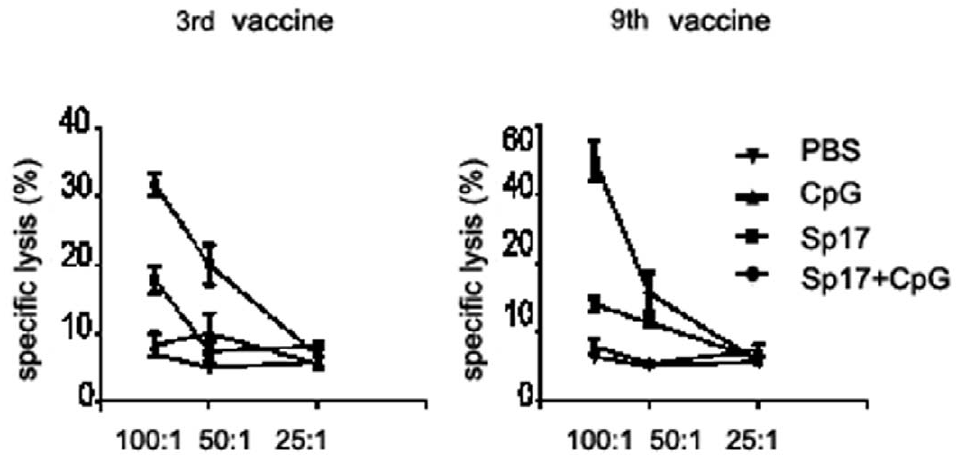
Figure 9. Cytotoxicity assay in the therapeutic regimen. Splenocytes from the three different formulations of therapeutically vaccinated mice and controls were collected and analyzed by 51 Chromium-release assay. These results show three independent experiments after third vaccine (day 97) and ninth vaccine (day 270), using splenocytes as effector cells and ID8 as target cells. X axis indicate effector:target ratios.